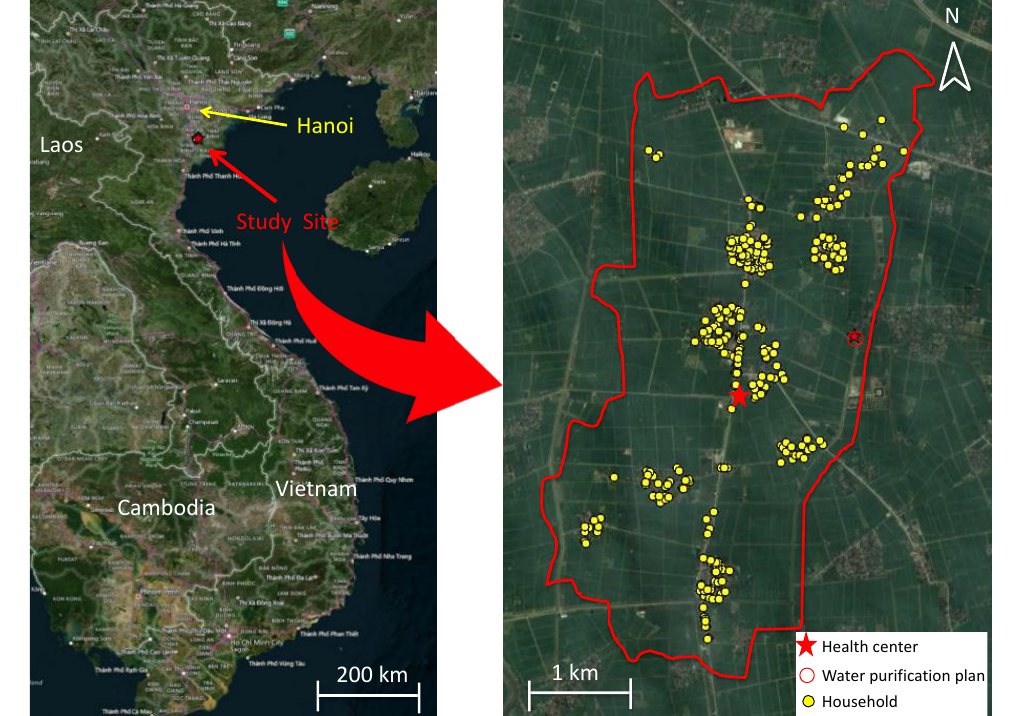
Figure 2. Visualization of sampling locations in Hien Khanh commune. Table 1. Characteristics of the household and individuals.